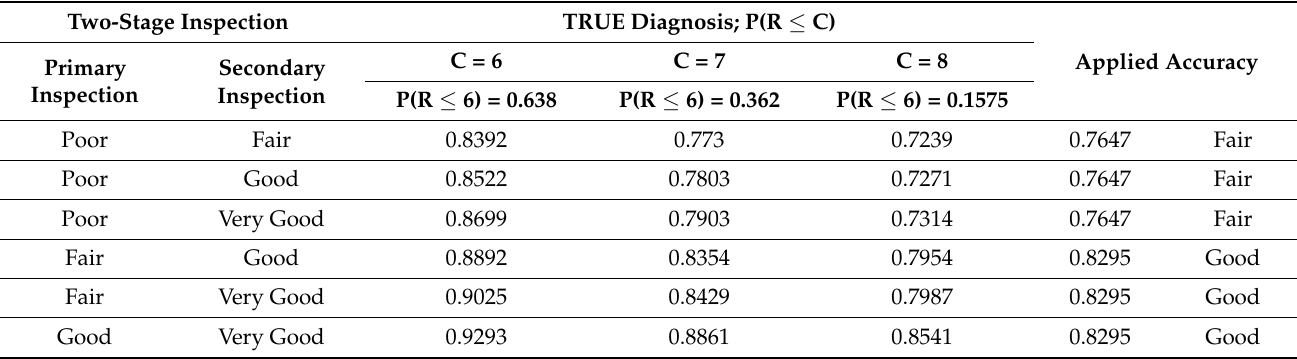
Table 3. Accuracy of two-stage inspection in different combinations of accuracy levels